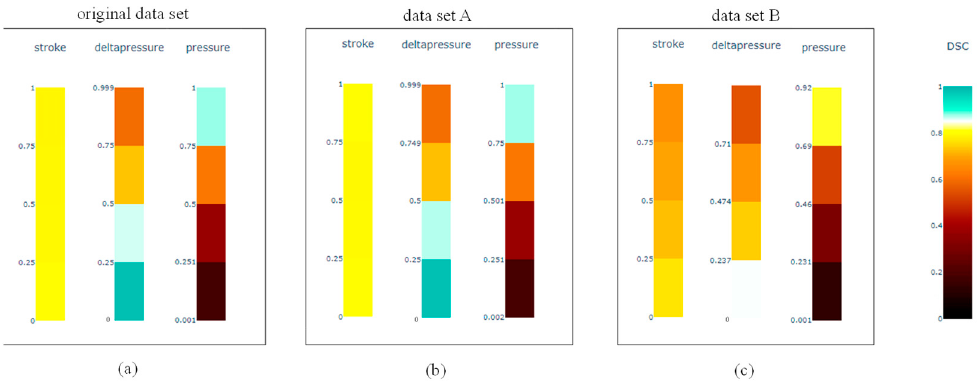
Figure 15. Visualization of data set completeness of ( a ) the original data set, ( b ) data set A and ( c ) data set B.